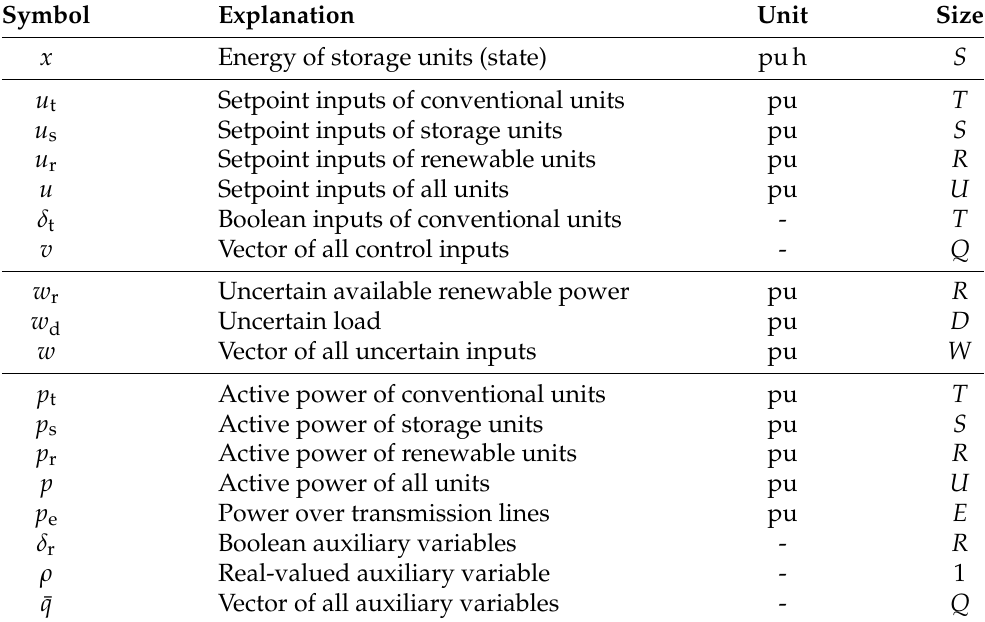
Table 1. Model-specific